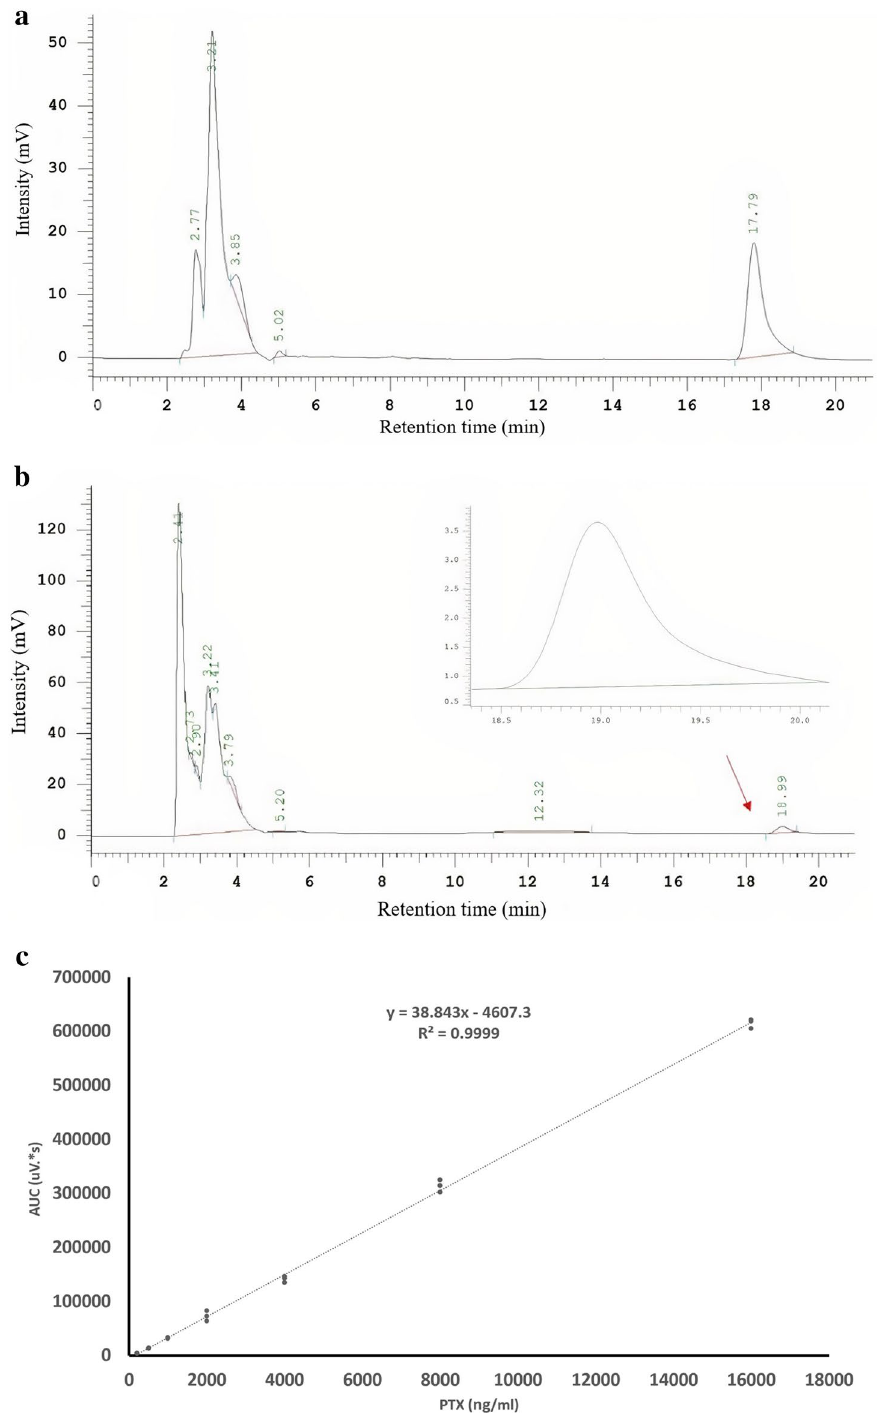
Figure 7. HPLC curve of PTX. ( a ) The PTX-related peak was observed near 18 min in the control culture medium. ( b ) the peak of PTX appeared at 18.99 min in the hAEC-PTX/CM sample. ( c ) The standard calibration curve of pure PTX which shows y = 38.843x—4607.3, R 2 =